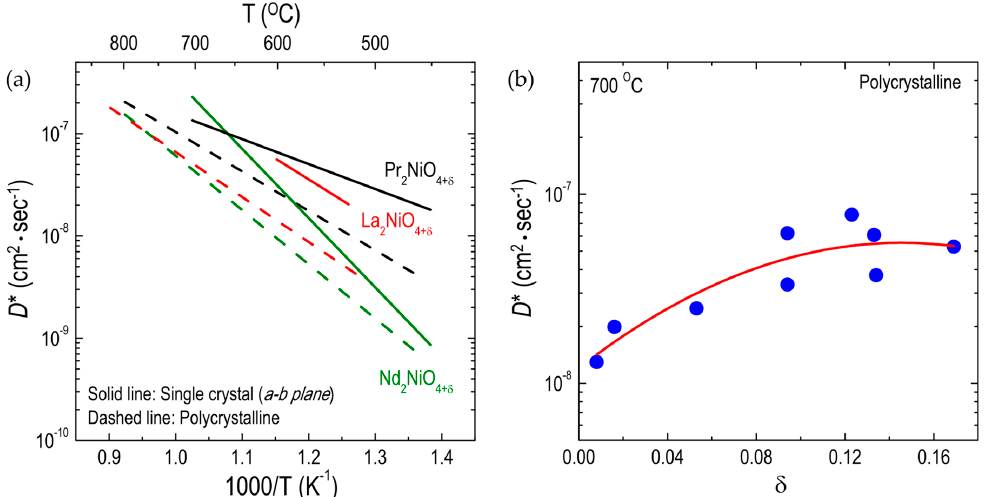
Figure 4. Arrhenius plots of oxygen tracer diffusivity ( D *) for different RP oxides: ( a ) Effect of A-site substitutions on D * for A 2 NiO 4+ δ (A = Pr, La, and Nd) single crystalline and polycrystalline oxides: single crystal (Ref. [49,97]) and polycrystalline (Ref. [51]); ( b ) Dependences of D * on the oxygen nonstoichiometry in A 2 NiO 4+ δ (A = Pr, La, and Nd) polycrystalline oxides (Ref. [51]).